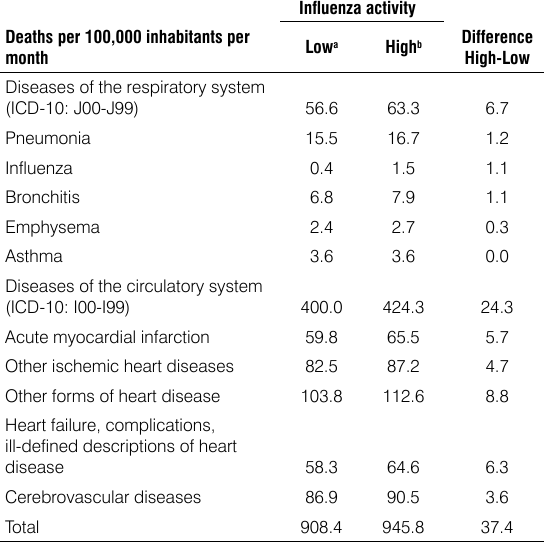
Table 2. Mean differences in number of deaths per 100,000 inhabitants between seasons with high vs. low influenza